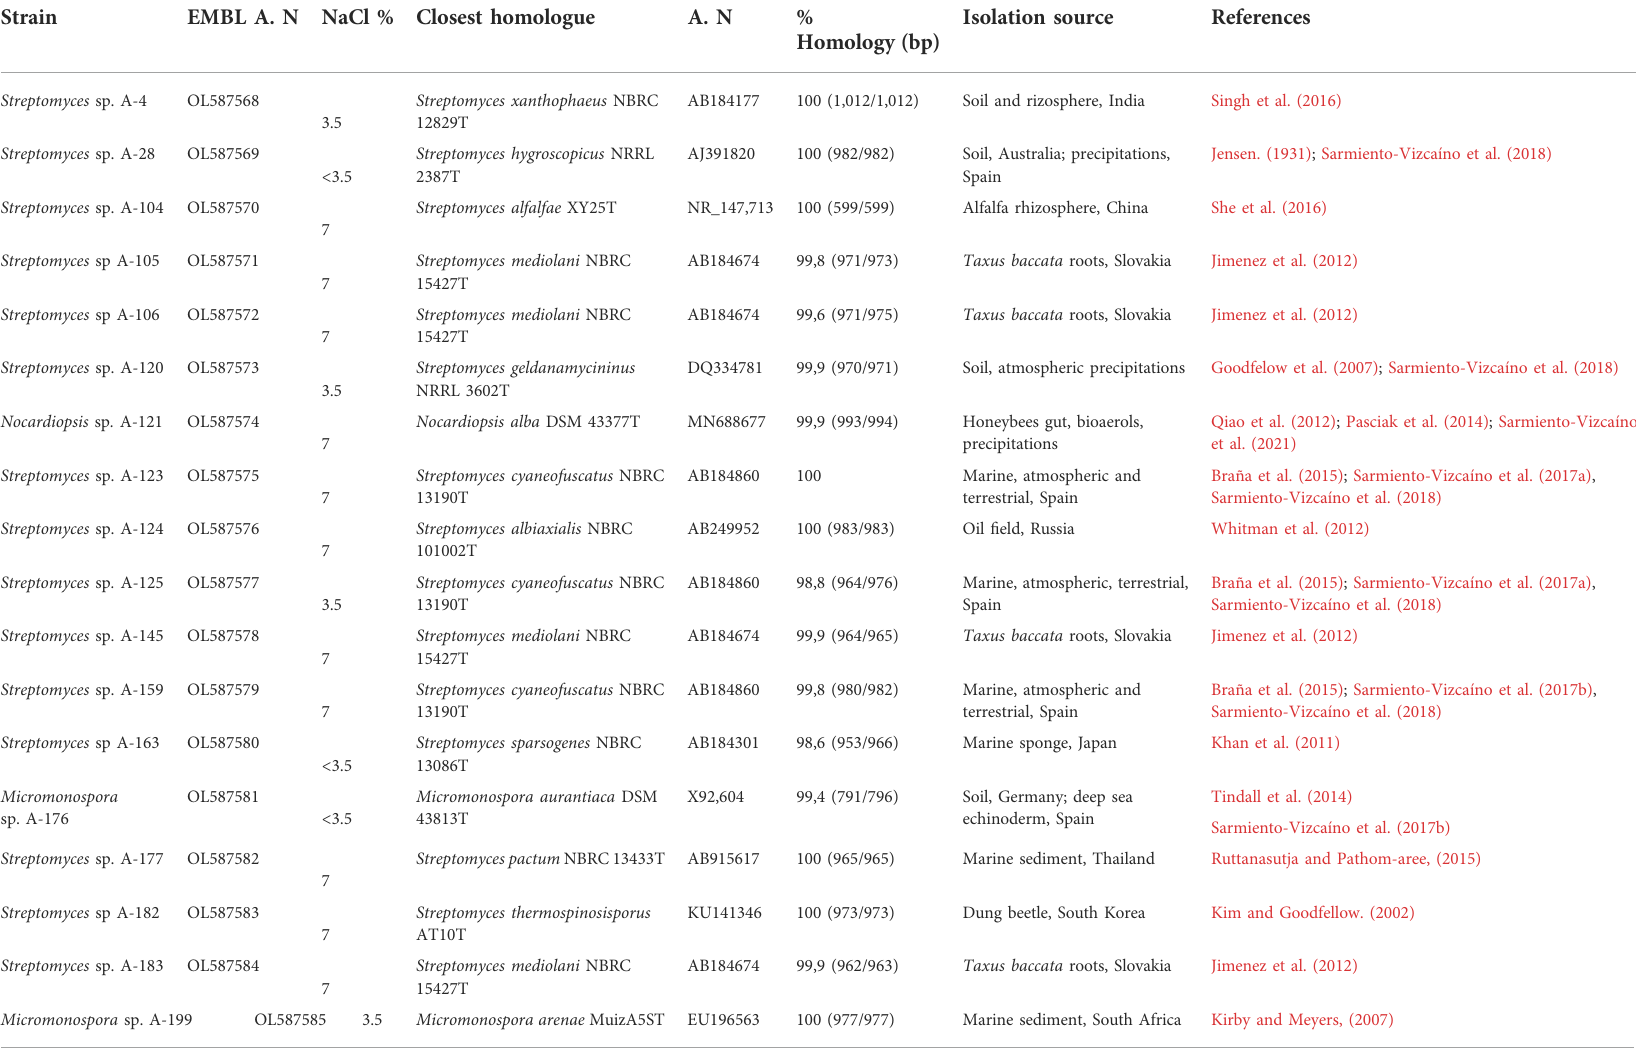
TABLE 2 Phylogenetic diversity of Actinobacteria